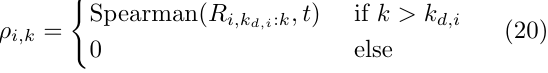
Figure 2: Collection of RMS trends with FTs for the IMS dataset. (a) R Hz; (c) R [1600, 2000] Hz; (d) R [400, 800] Hz. 5 2 bands with 400 Hz bandwidth ( N = 25), and R is cal- b i culated for each band using (11). The mean value and standard deviation of each R are calculated using the i baseline vibration values within the first 30 hours ( k ∈ [1 , 180]). With these values, the FTs for each R are i calculated using (15) after determining m with